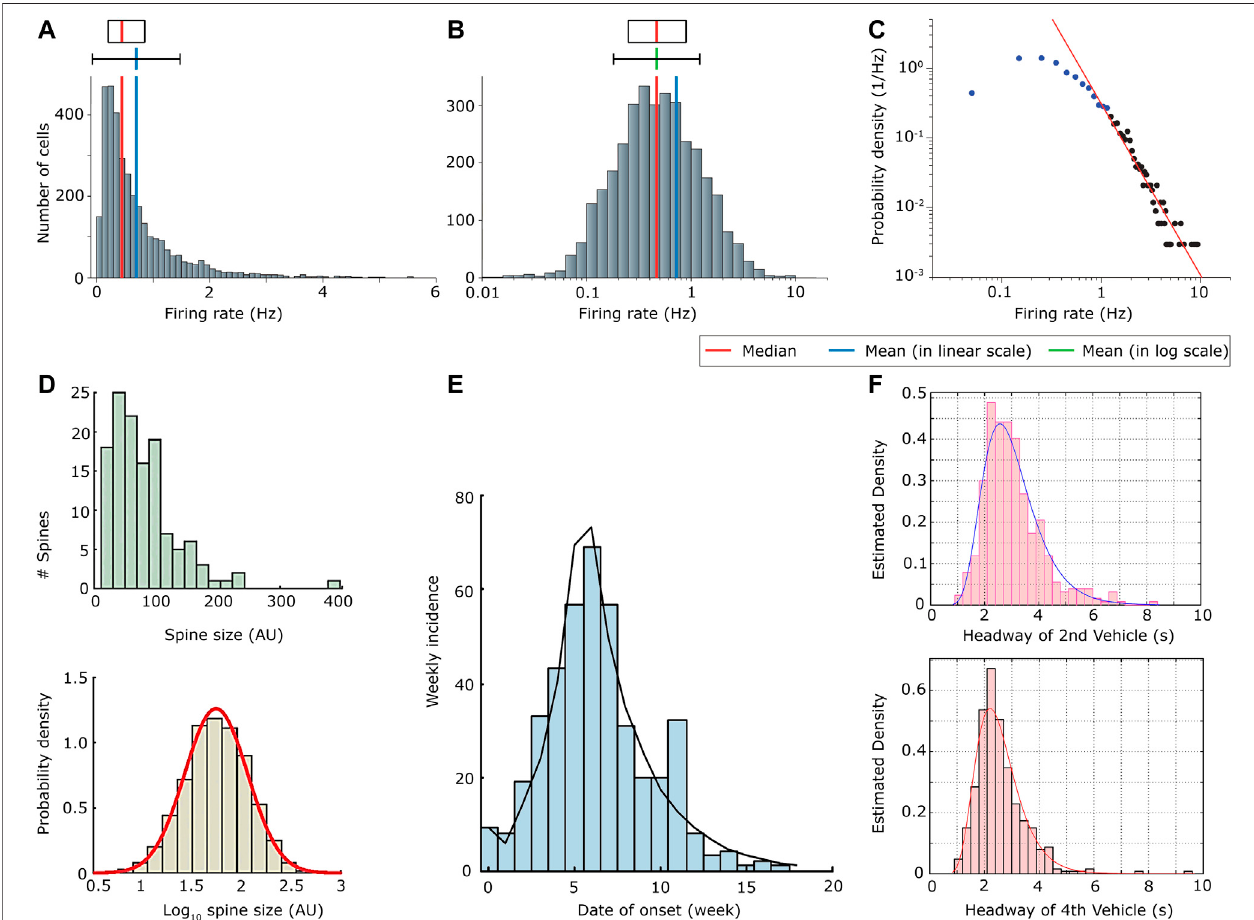
FIGURE 1 | (A) Non-normalized distribution of fi ring rates of hippocampal CA1 pyramidal neurons during slow-wave sleep. The fi ring rate is measured in Hz; (B) Distribution(non-normalized)ofthelogarithmofthe fi ringrateasin (A) ; (C) Distributionofthe fi ringrateasin (A) inalog-logplot.Noticethatbytakingintoaccountonlythe tail of the distribution (black dots), the distribution could be fi tted by a power-law, even though we may be missing some important information; (D) Distribution of the spine sizeinarbitraryunits (AU)(top), and probabilitydensity ofthelogarithm ofthe spinesize(bottom); (E) Distributionofthe newnumber ofEbola cases per week (week incidence); (F) Probability density of the lag times at which 2 vehicles waiting at rest at a traf fi c light pass the stop line. This is what is called headway. The distributions are reported for the lag between two successive vehicles considering the second position (top) and the fourth position (bottom) of the line: for instance the bottomplotdescribesthedistributionofthedifferenceoftimesatwhichthethirdandthefourthvehicleofthequeuecrossthestopline.Alltimesaregiveninseconds; (A) (B) and (C) are adapted from [17] (D) is adapted with permission from [23] (E) is reproduced with permission from [24] and (F) from